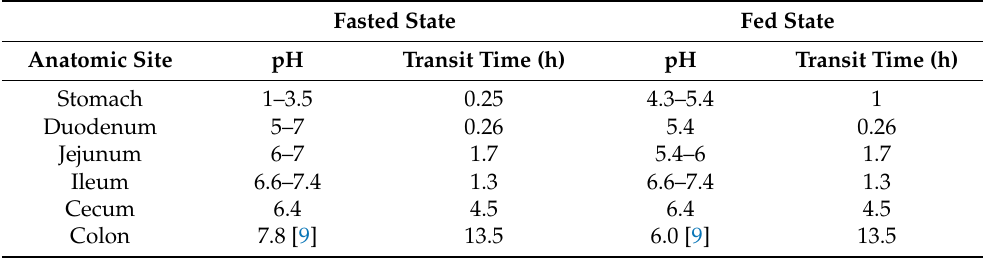
Table 1. The pH values and the transit time at different anatomic sites of the human GI tract. Adapted with permission from Ref. [8]. 2023, John Wiley and Sons. Fasted State Fed State Anatomic